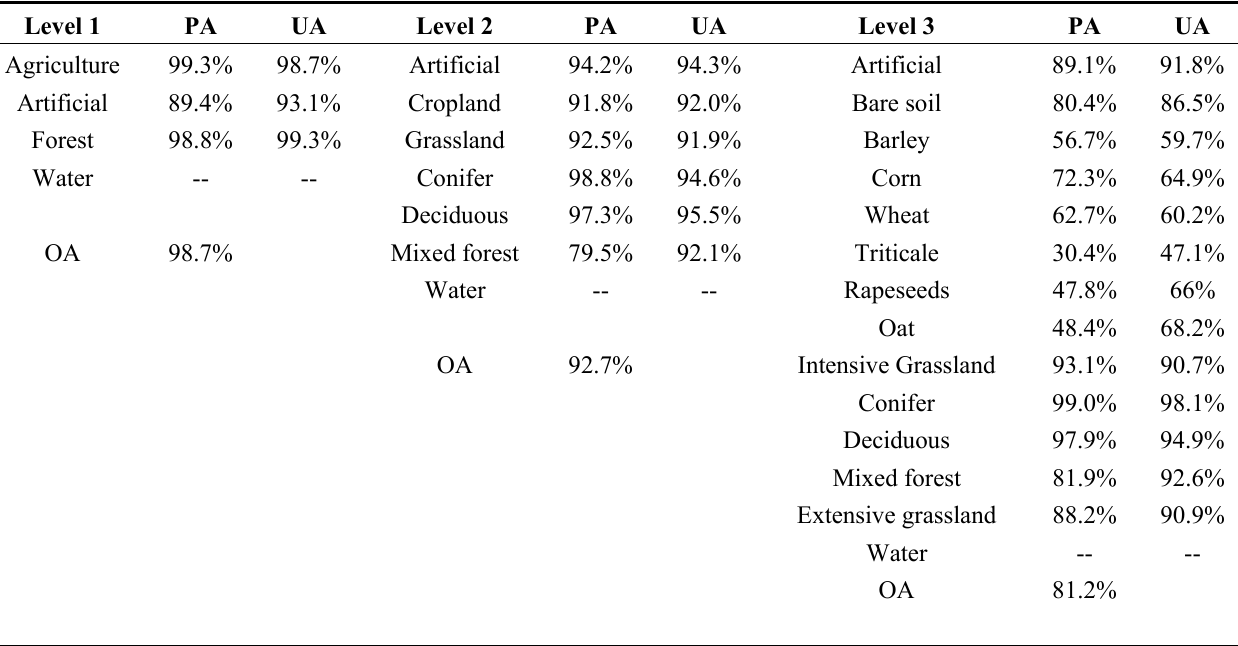
Table 5. The best classification accuracy statistics from the 10-fold validation by Random Forest chosen for the data analysis of the single Landsat 8 image with 10 bands combination in 2013. PA refers to the Producer’s accuracy, UA refers to the User’s accuracy, -- represents no validation pixel